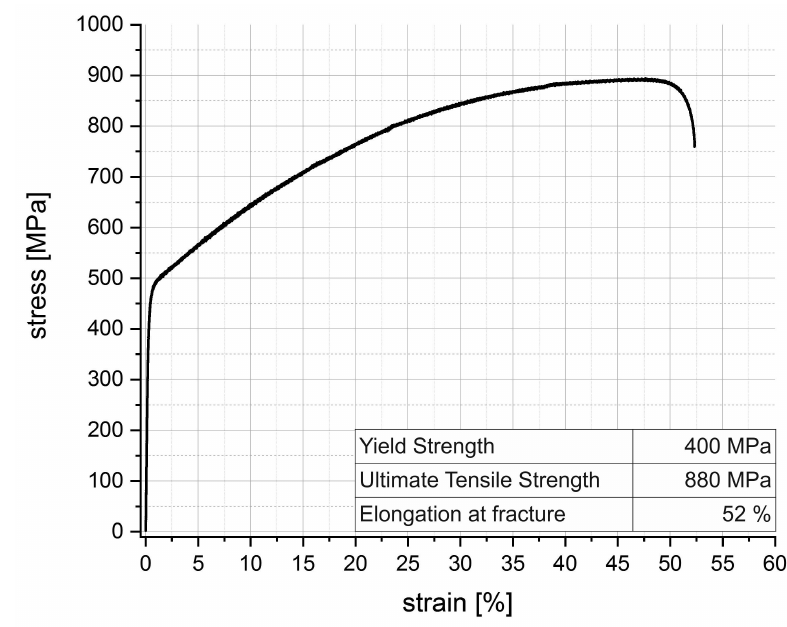
Figure 3. Stress–strain diagram for the as-received twinning-induced plasticity (TWIP) steel tested at room temperature. The inset summarizes the most important characteristic values.